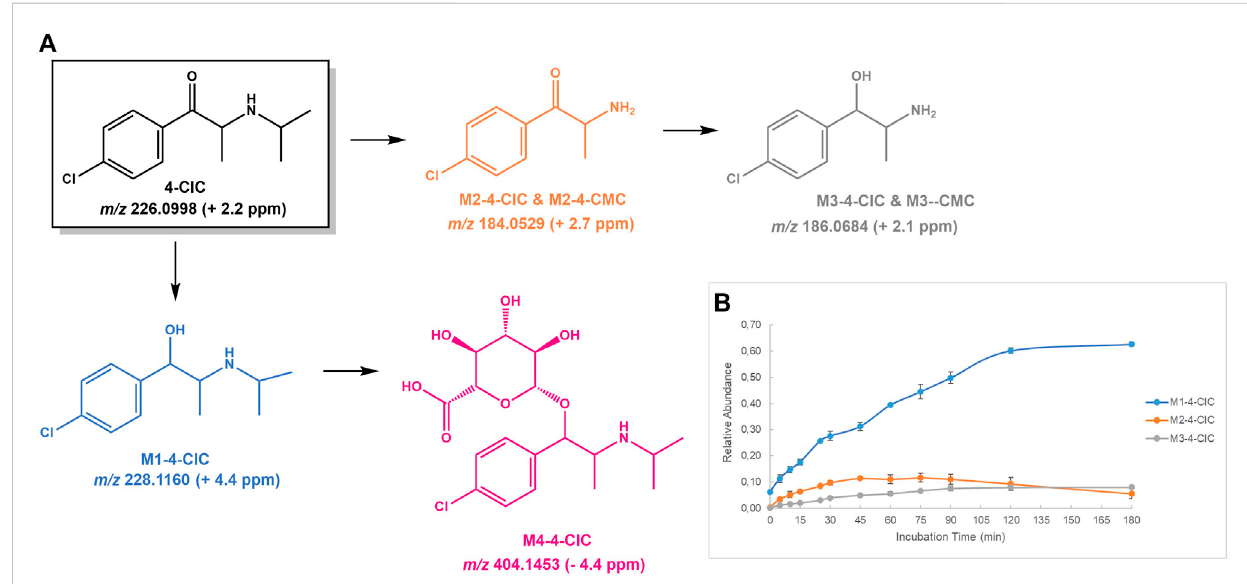
FIGURE 4 (A) Proposedstructuresofthe 4-CIC PhaseIandIImetabolitesidenti fi edbyLC-HRMS/MSanalysisinHLMincubation;and (B) Relativeabundanceof 4-CIC Phase I metabolites over HLM incubation